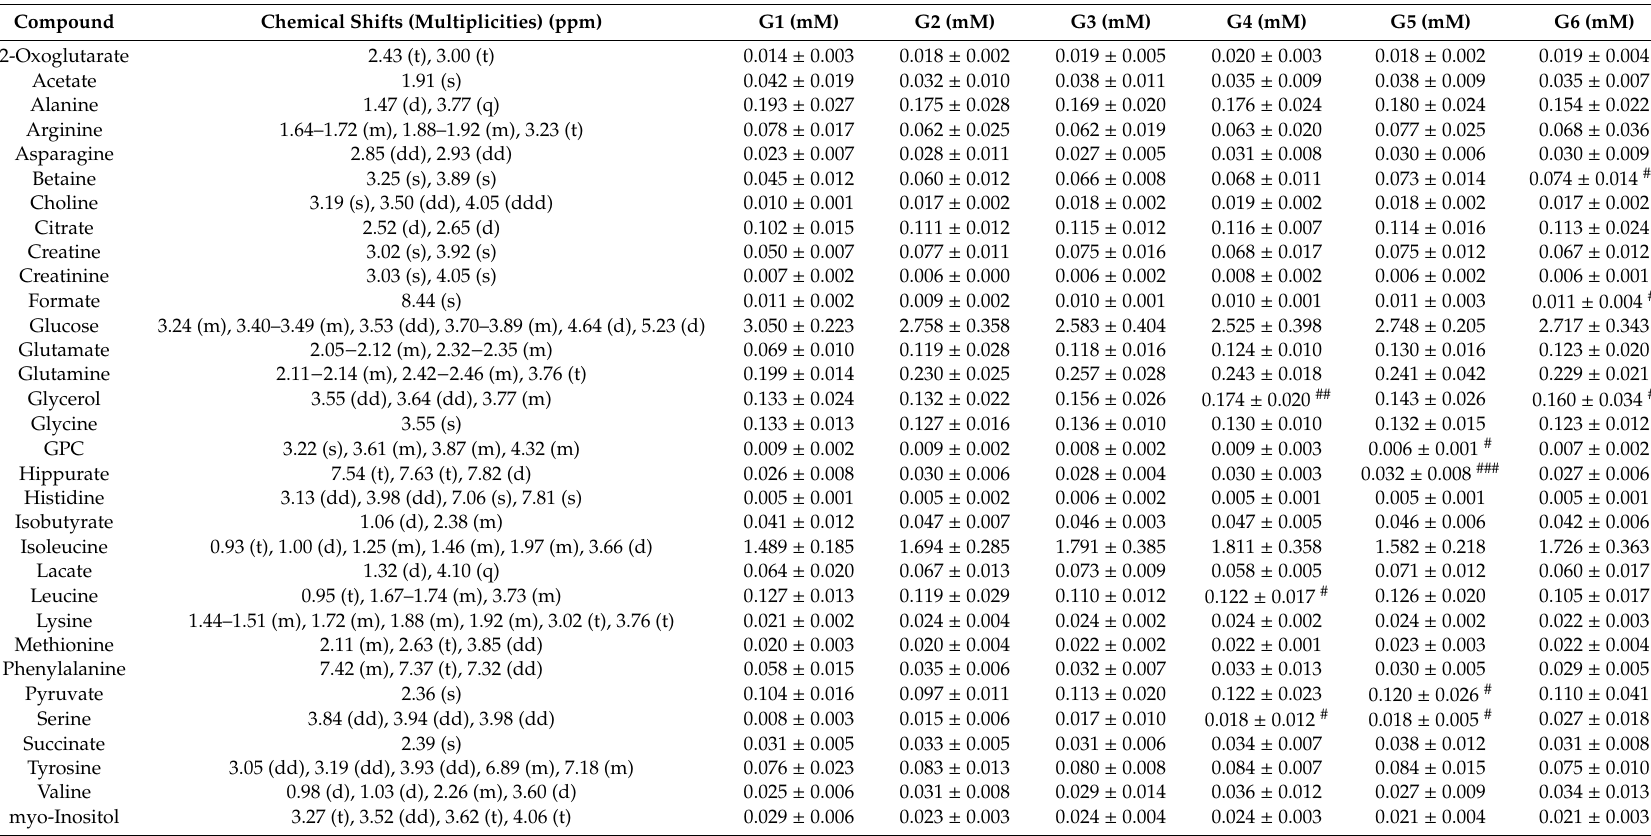
Table 1. Identified and quantified metabolites in serum sample from 1 H-NMR spectra. Values are means (mM) ± standard deviations of